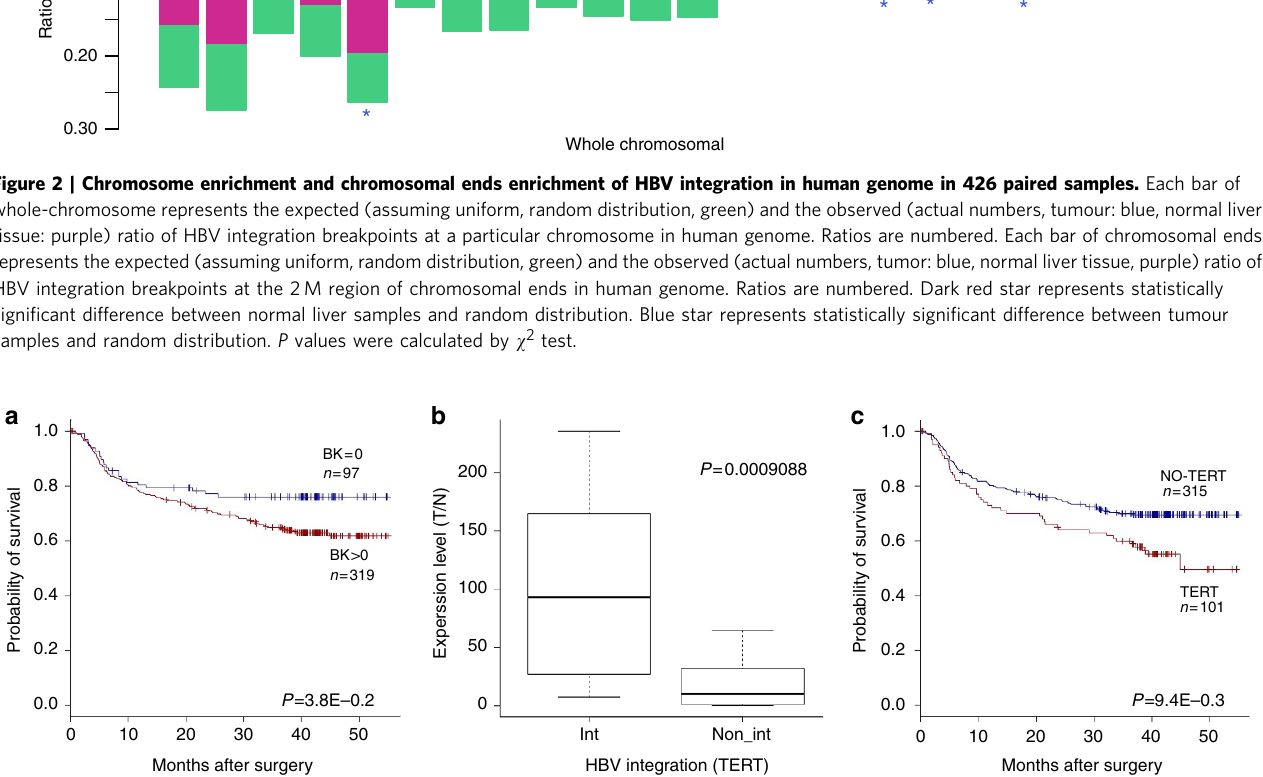
Figure 3 | Clinical correlation analysis of HBV integration in HCC. ( a ) Kaplan–Meier survival curves for individuals with (BK 4 0, n ¼ 319) versus without (BK ¼ 0, n ¼ 97) HBV integration breakpoints by log-rank test. Those who lacked prognostic information were excluded from the analysis ( n ¼ 10). ( b ) Gene expression levels of TERT that frequently harboured HBV integrations in samples with versus without HBV integration events. Gene expression was normalized by the corresponding adjacent, normal control and is represented as the tumour/normal gene expression level. P values of unpaired Student’s t test are shown. In the box plots, the median (50th percentile) is the middle line, with the bottom and top of the box representing the 25th and 75th percentiles of the data, respectively. The ends of the whiskers represent the lowest and highest data within the 1.5 interquartile range (IQR). IQR was defined as the distance between the lower and upper quartiles of the data. ( c ) Kaplan–Meier survival curves for individuals with ( n ¼ 101) versus without ( n ¼ 315) HBV integration in TERT by log-rank test.